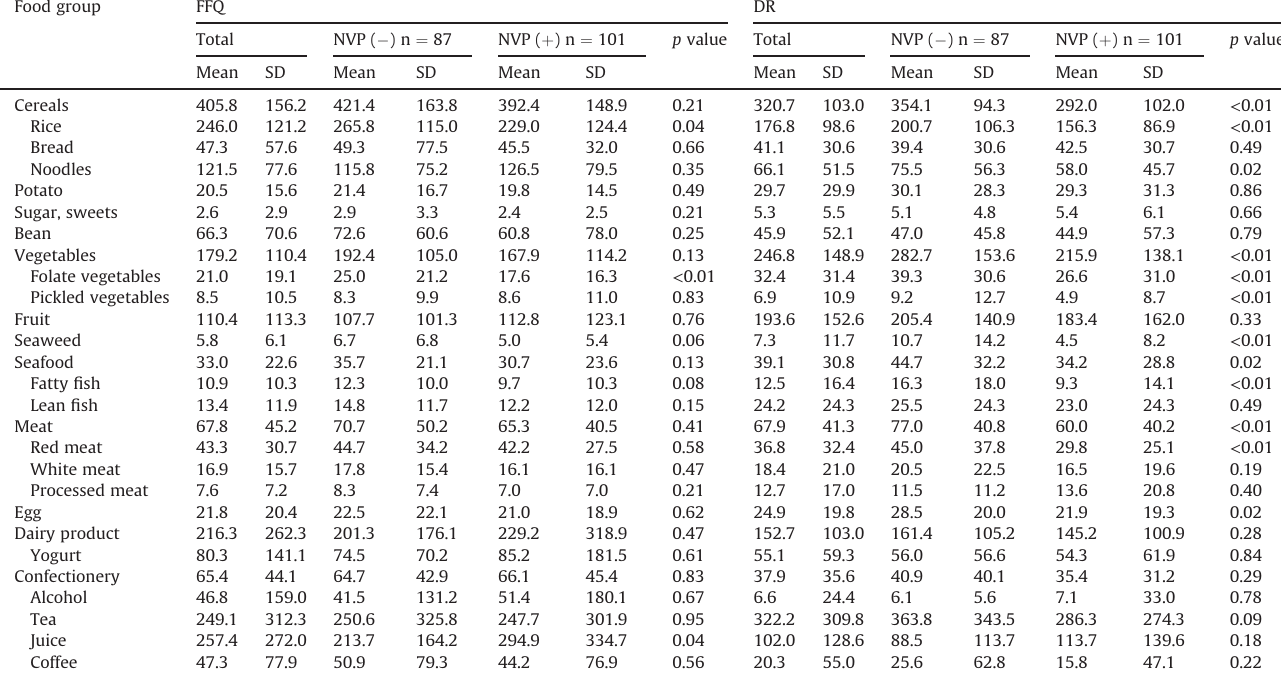
Table 3 Estimated mean intakes of food groups (g/day) from DR and FFQ. Food group FFQ